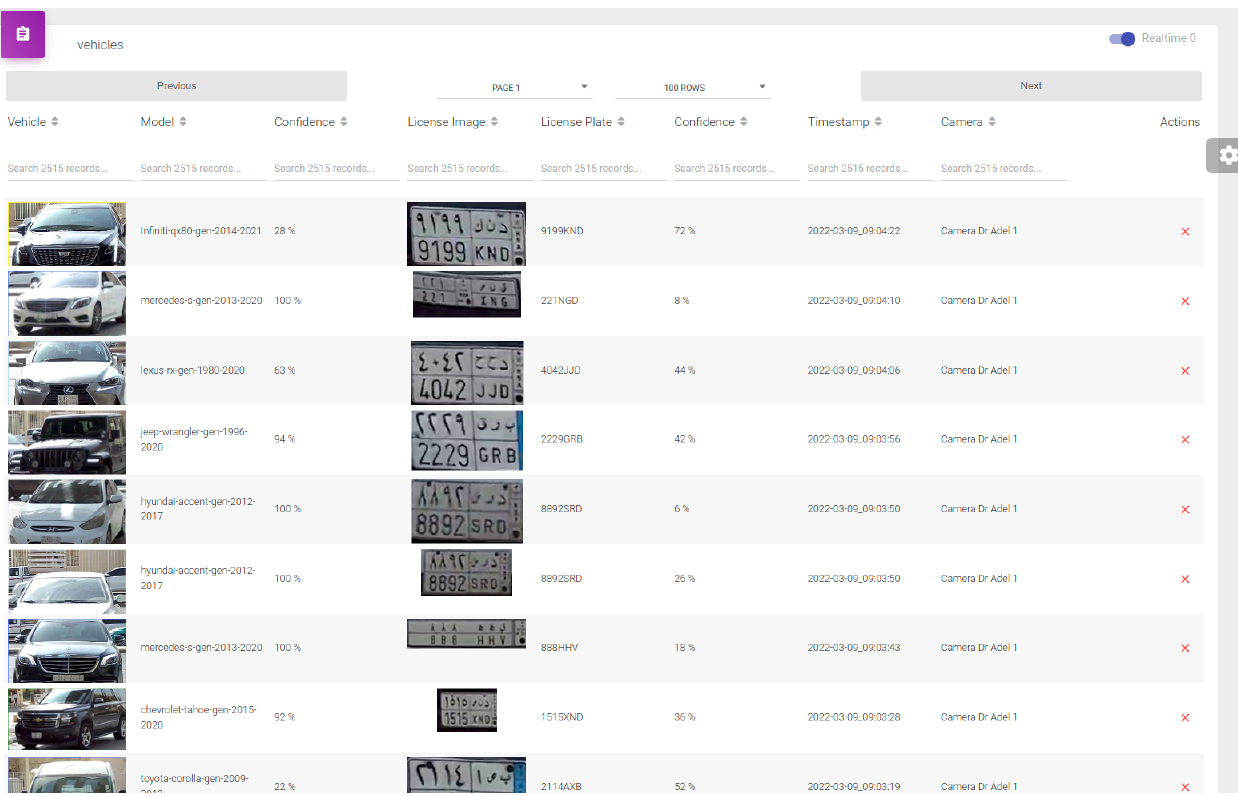
Figure 12. Screenshot of the vehicle web interface that displays car information received from the edge